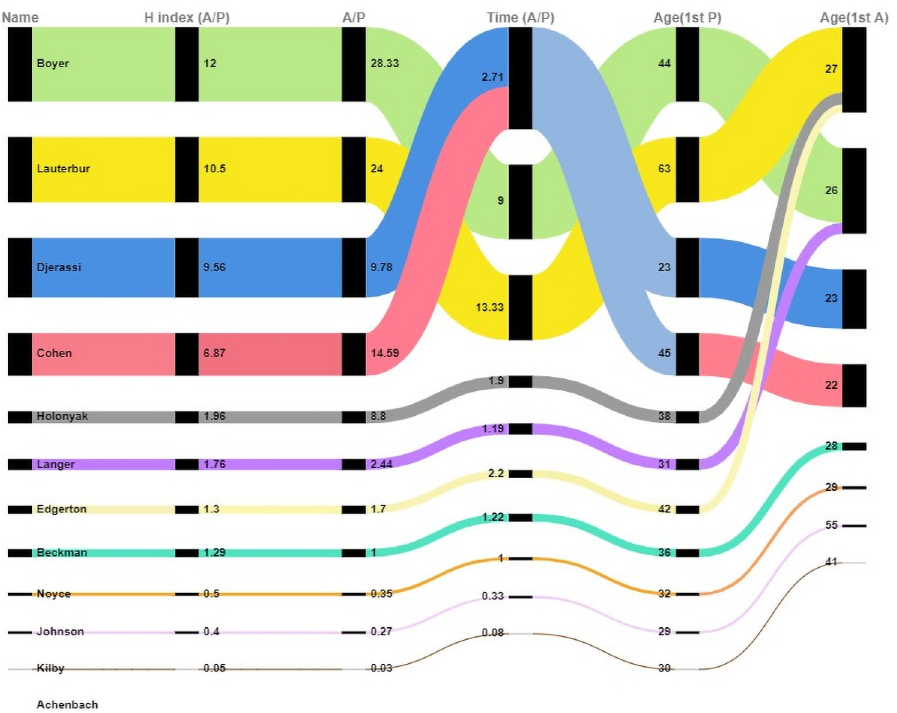
Fig 4. Differences in three ratios of articles to patents by scientist and the ages at which each scientist began publishing and patenting.